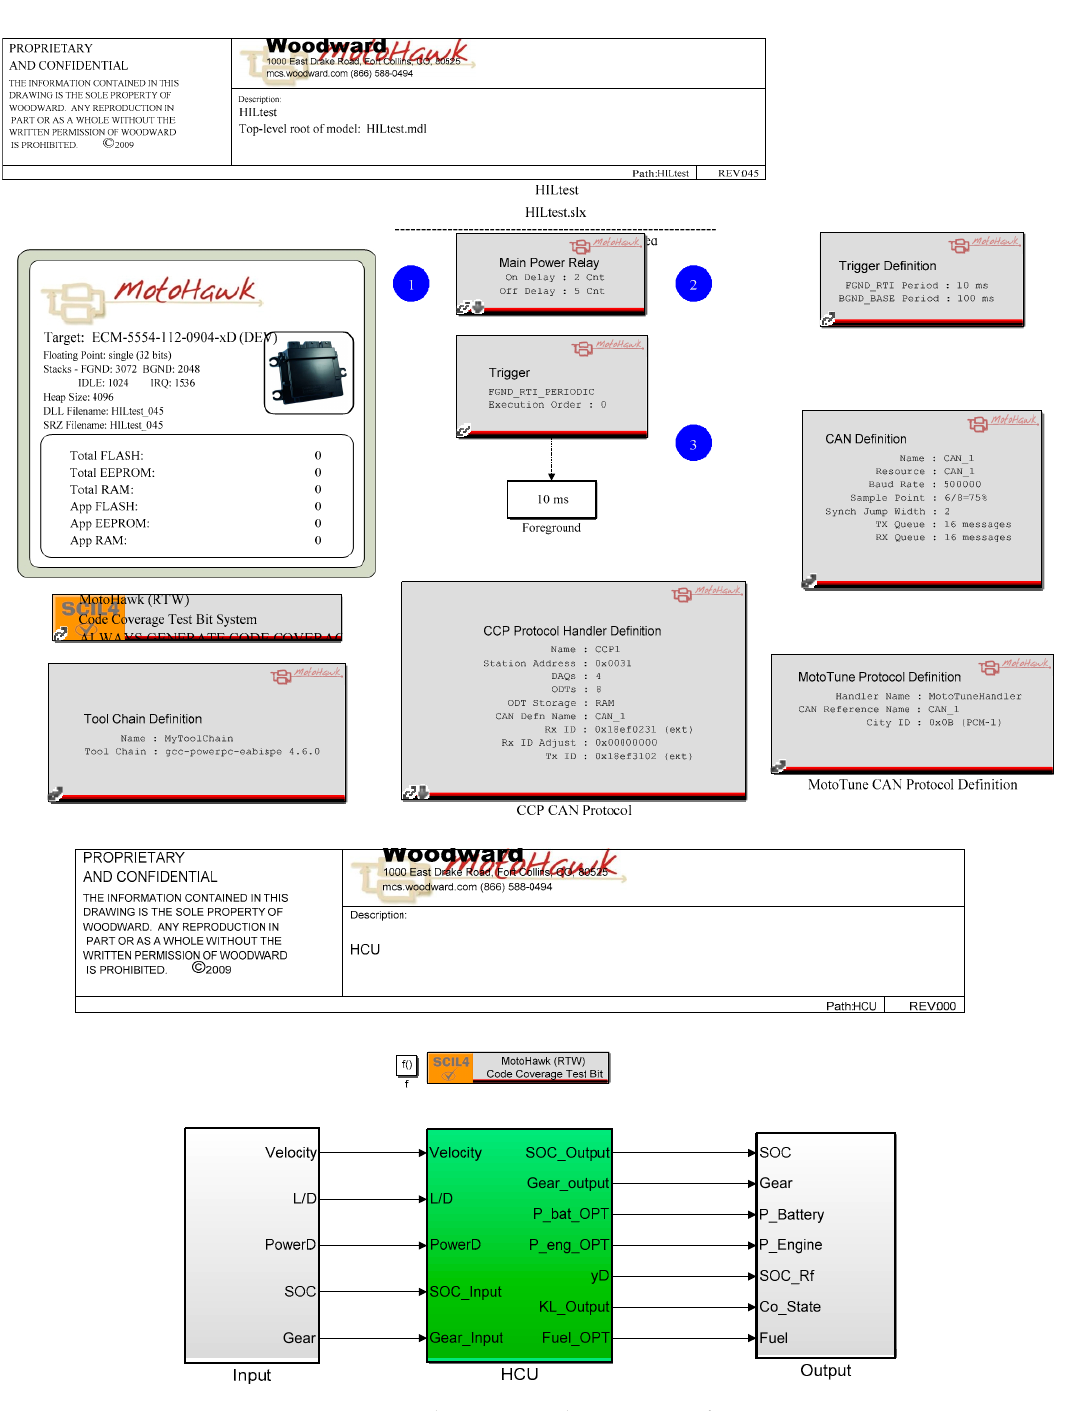
Figure 18. The MotoHawk-project interface.